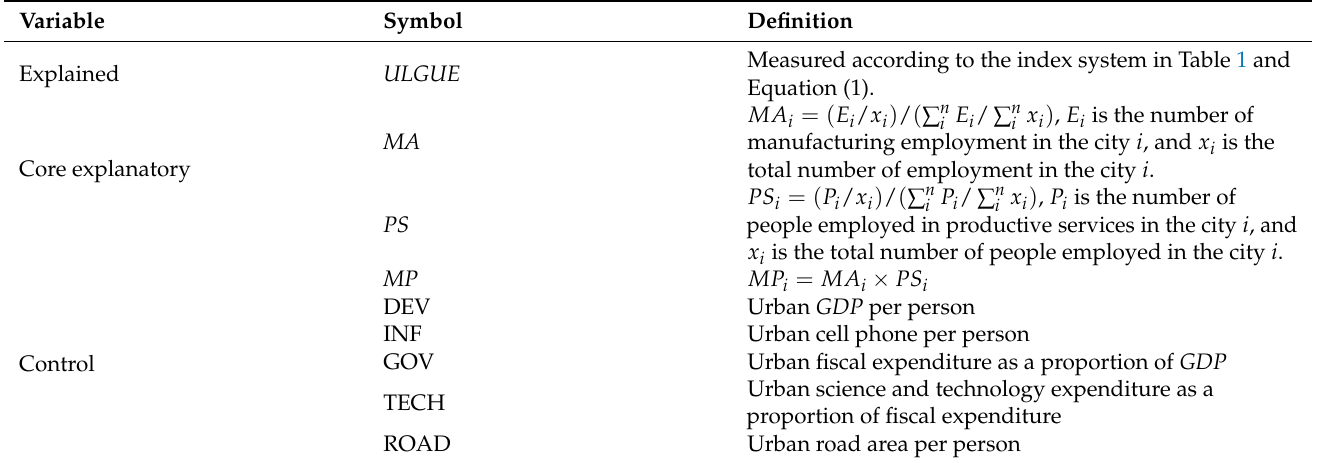
Table 2. Description of variables.